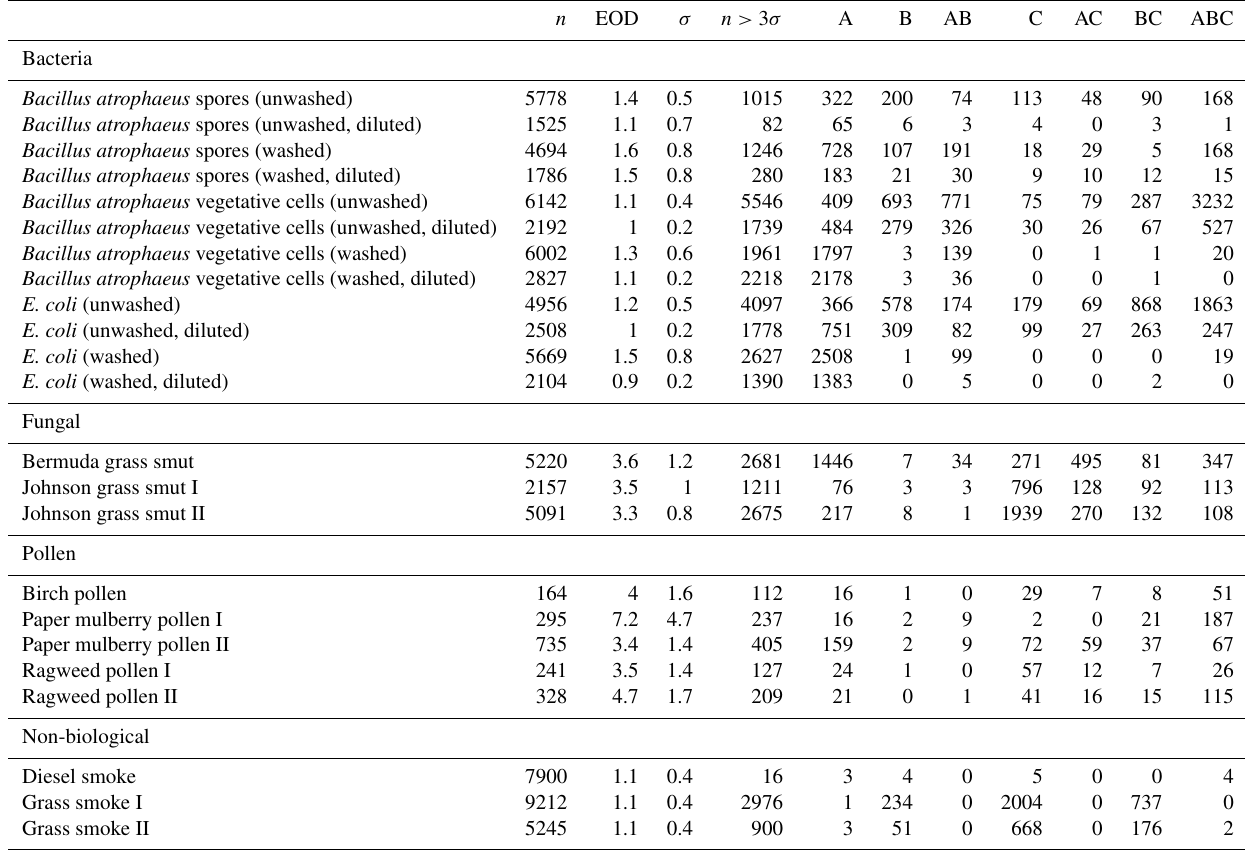
Table B1. For the data collected in 2008, a summary of size and fluorescent measurements for each sample to include: the number of particles in the sample (total), average equivalent optical diameter (EOD), standard deviation of the size ( σ ), the number of points that exceeded a fluorescent threshold of 3 standard deviations above the average forced trigger measurement ( n > 3 σ ), and ABC counts using a 3 σ